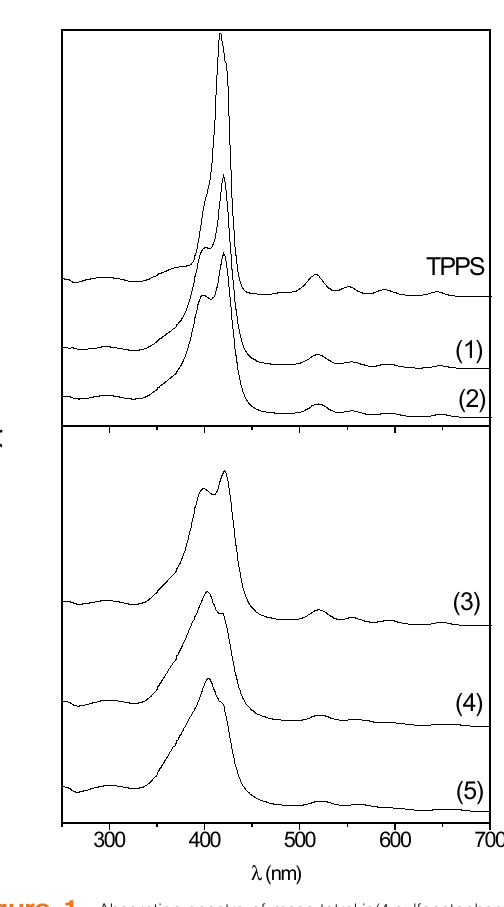
Figure 1. Absorption spectra of meso-tetrakis(4-sulfonatophenyl) porphine in formamide solution (TPPS) and in formamide dispersions with LDH3. The ratios of the dye and LDH3 were 0.05(1), 0.10(2), 0.25(3), 0.40(4) and 0.50(5) mmol g -1